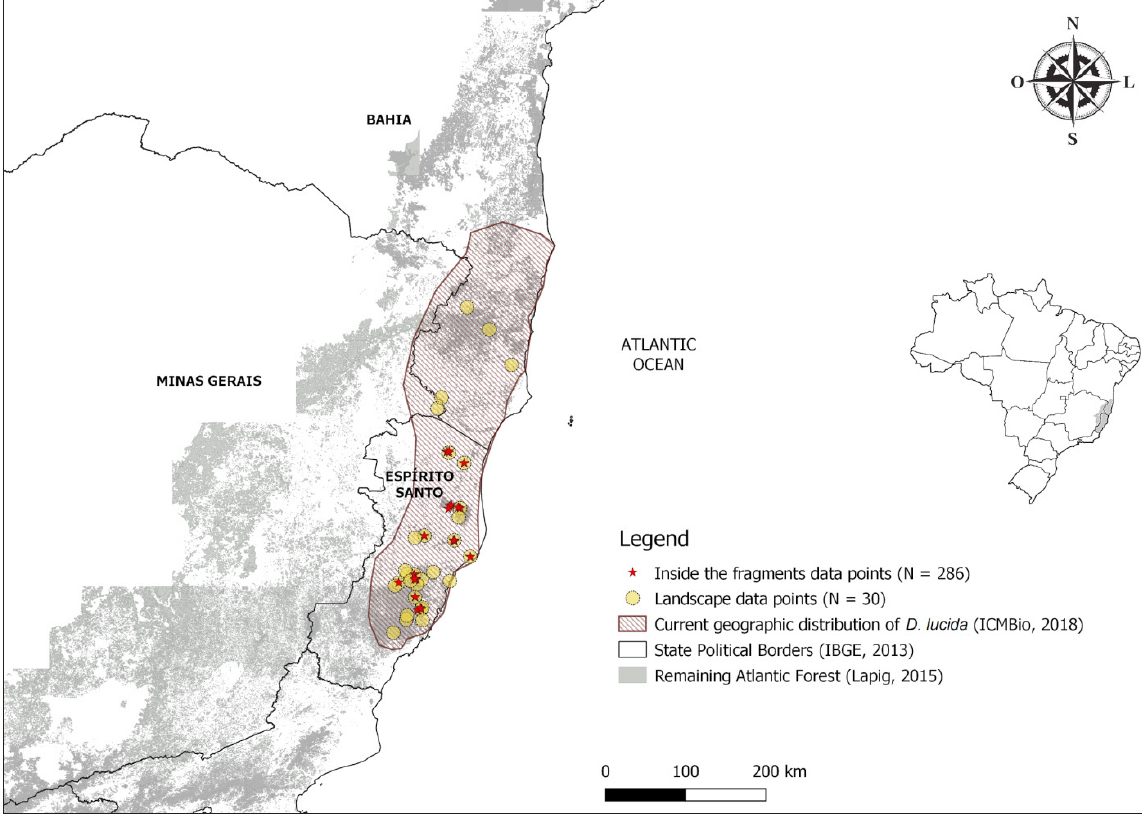
Fig 1 . Data sampling points of this study and current geographic distribution of D. lucida , according to ICMBio